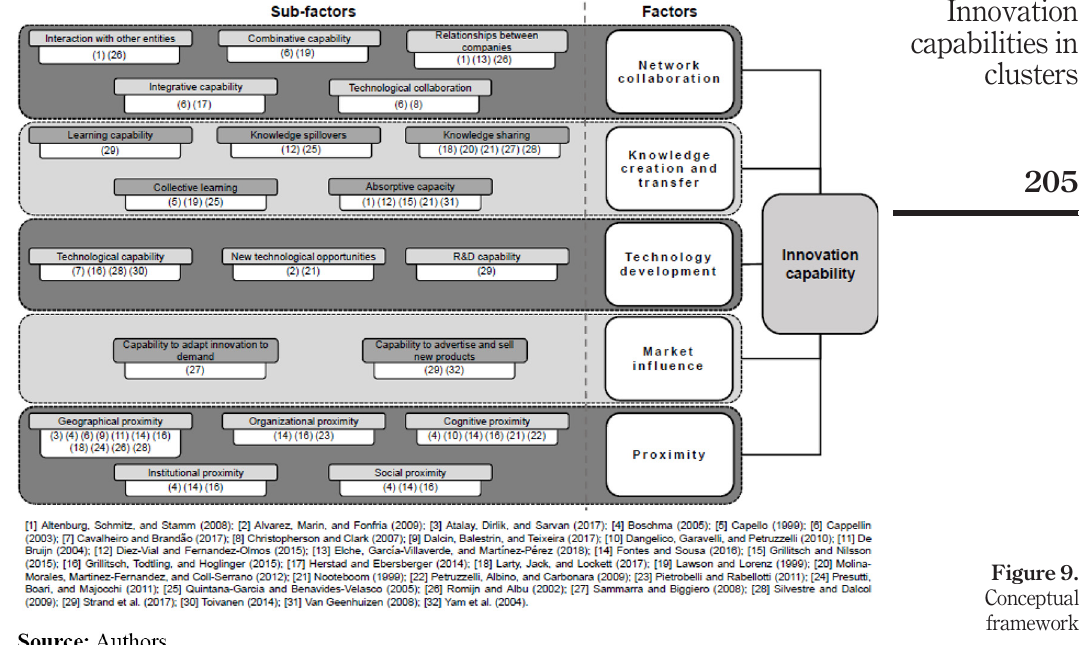
Figure 9. Conceptual